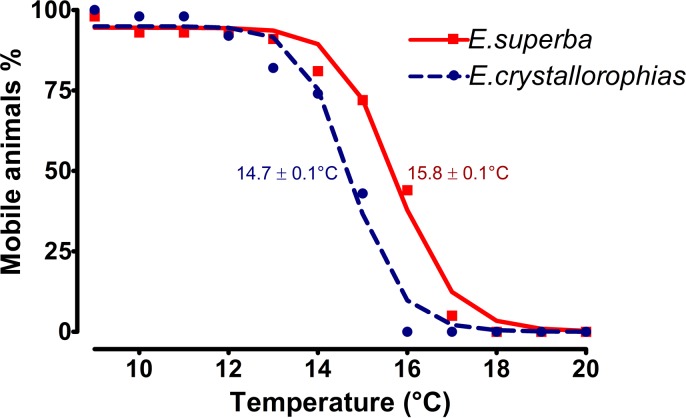
Curves representing the loss of mobility of a population of krill subjected to gradual temperature increase (0.1.min-1) (E. crystallorophias n = 130 blue curve; E. superba n = 43 red curve).CTmax is the temperature at which 50% of mobile animals are reached.